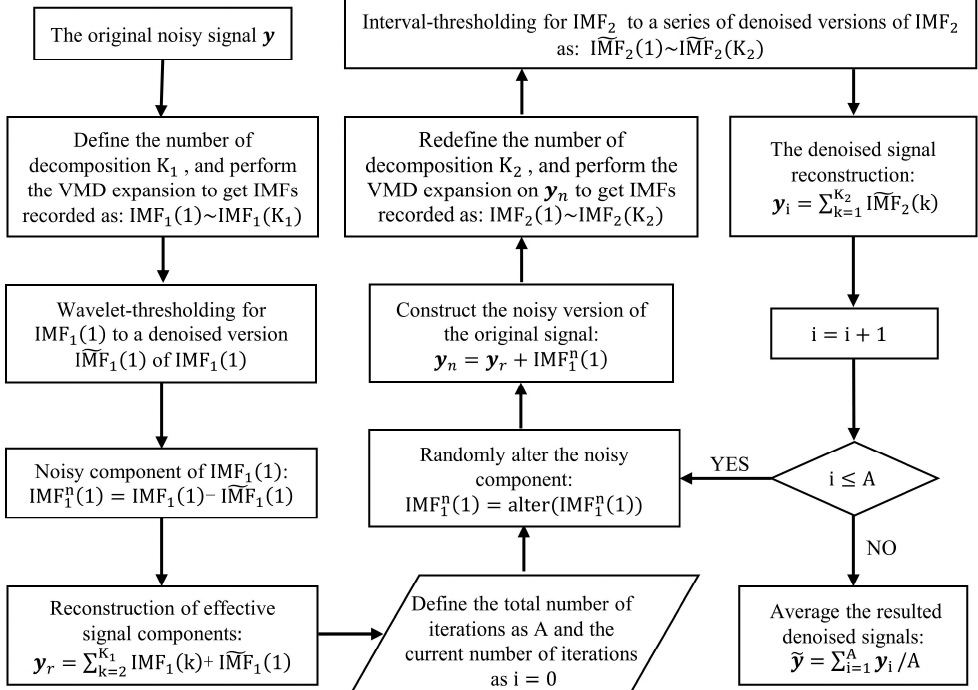
Figure 6. The algorithm chain of Iterative VMD Wavelet-Interval-Thresholding.